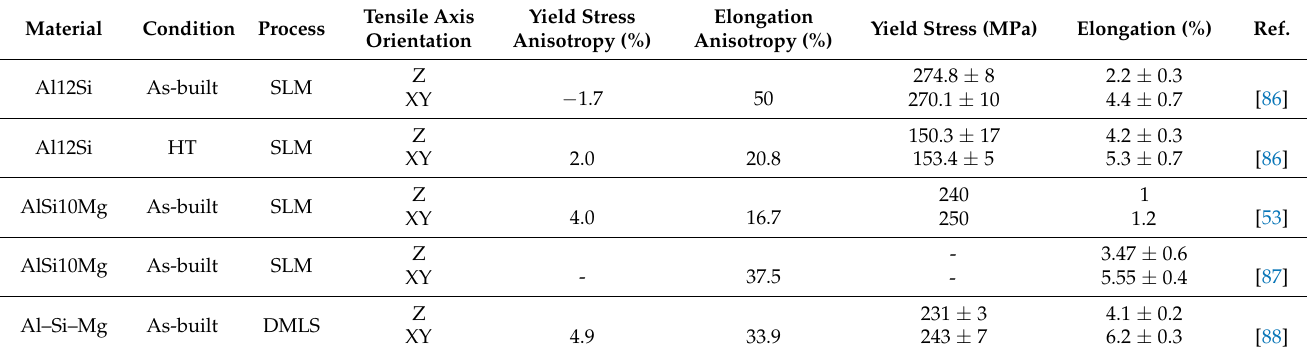
Table 1. Anisotropy of mechanical properties in some Al alloys. The anisotropy is defined by σ x − σ z Z is the vertical direction, parallel to the building direction, and X and Y are the horizontal